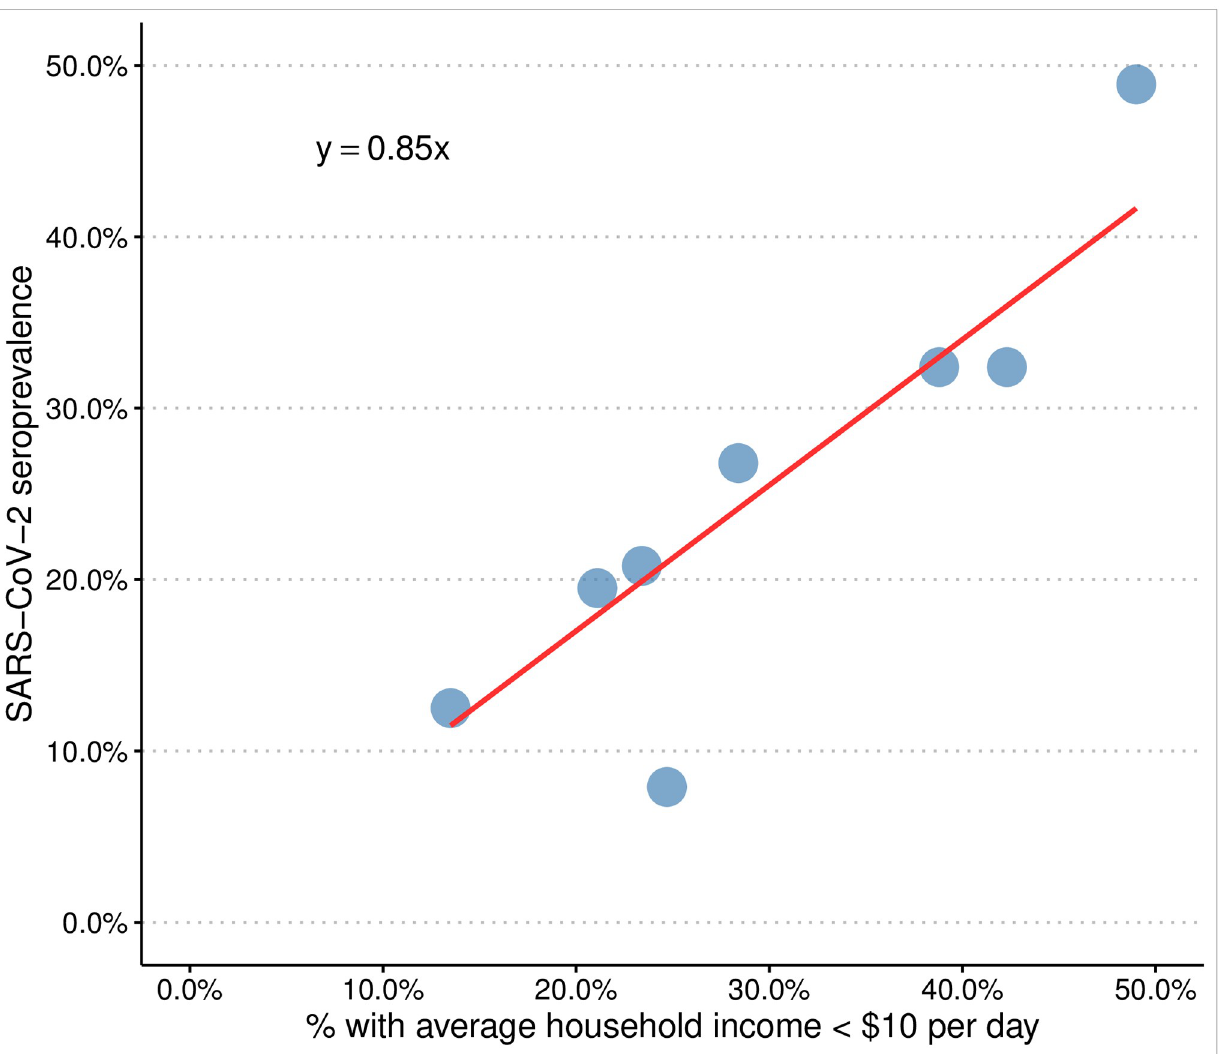
Fig 1. The correlation between the income and the SARS-CoV-2 seroprevalence within the subdistrict of residence of the study population. Income is denoted by the proportion of households with a daily income of < $10, with an increasing value implying a lower socioeconomic status.